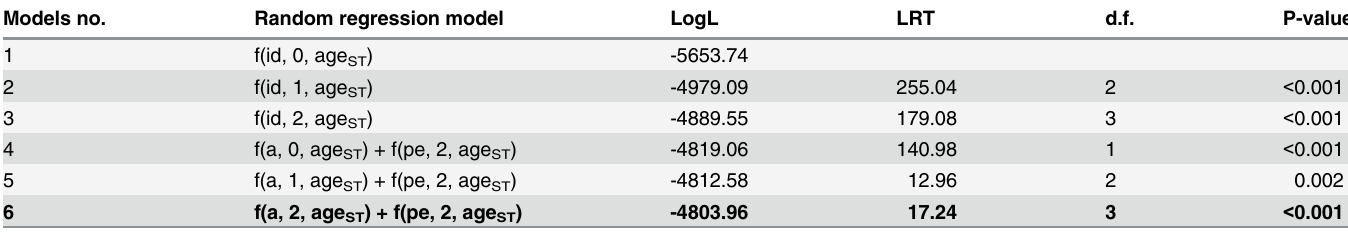
Table 4. Results of the selection strategy of the best random regression animal model for courtship display rate. LogL, the Log Likelihood of the model, LRT the likelihood ratio test, d.f., the degree of freedom defined as the number of random term(s) (variance(s) and covariance(s)) added for fitting each model in comparison of previous model. Note that f(indiv, 3, age ST ) did not converge A plot of the best model can be found in Fig 2 (using MCMCglmm estimates) and in S3 Text (using ASReml estimates). Models no.